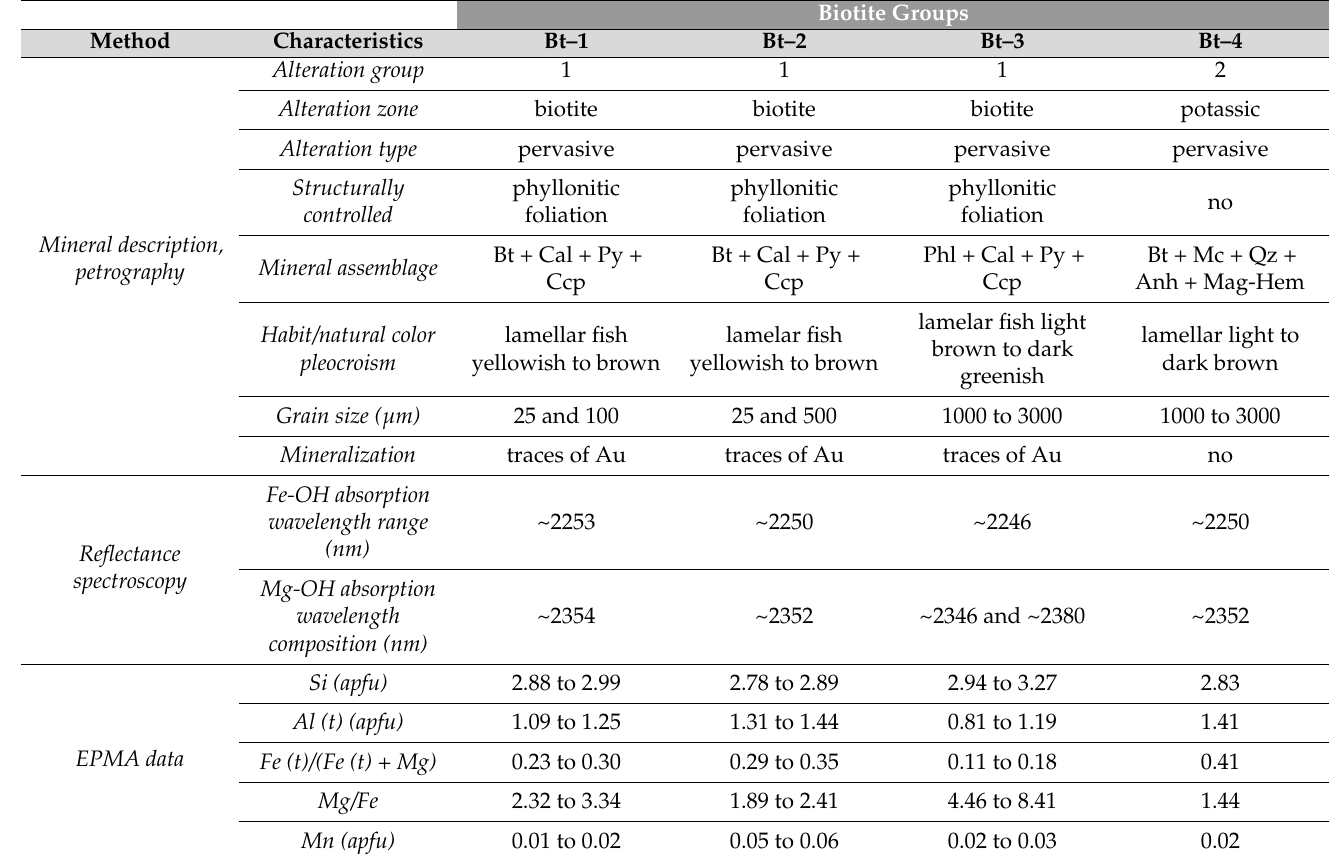
Table 2. Summary of the four groups of biotite described in the Para í ba deposit, based on the mineral characteristics, drill-core logging, petrography, reflectance spectroscopy, and